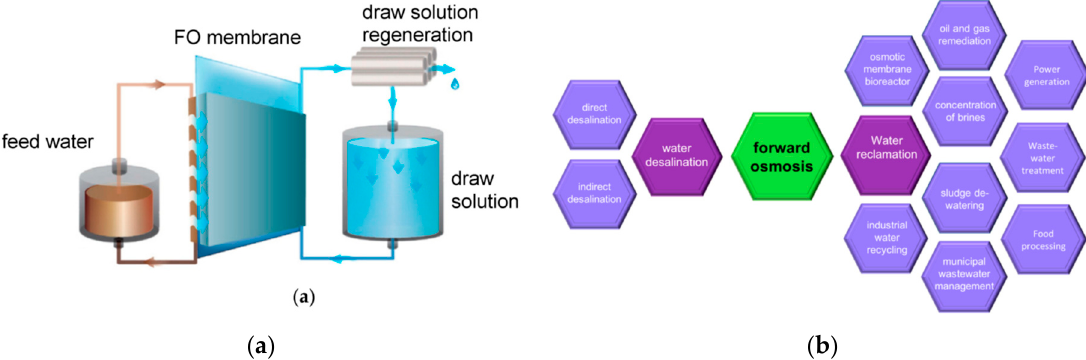
Figure 15. ( a ) Schematic illustration of typical FO process composed of membrane, feed and draw solution tanks and draw solution reconcentrated system. ( b ) Summary of the two main application clusters of FO processes, namely desalination and water treatment [184].